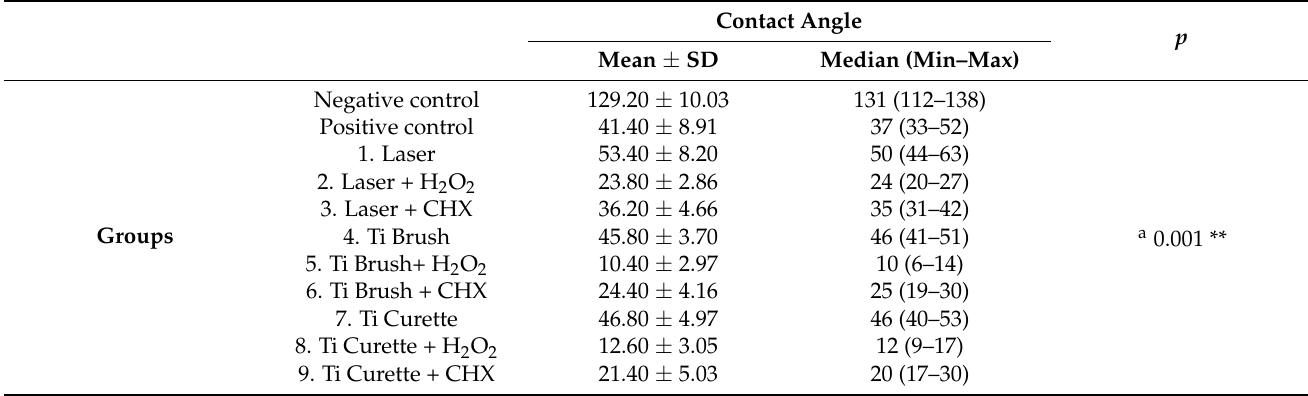
Table 3. Contact angle measurements and initial statistical analysis of groups (values in degrees). a Kruskal Wallis Test ** p <